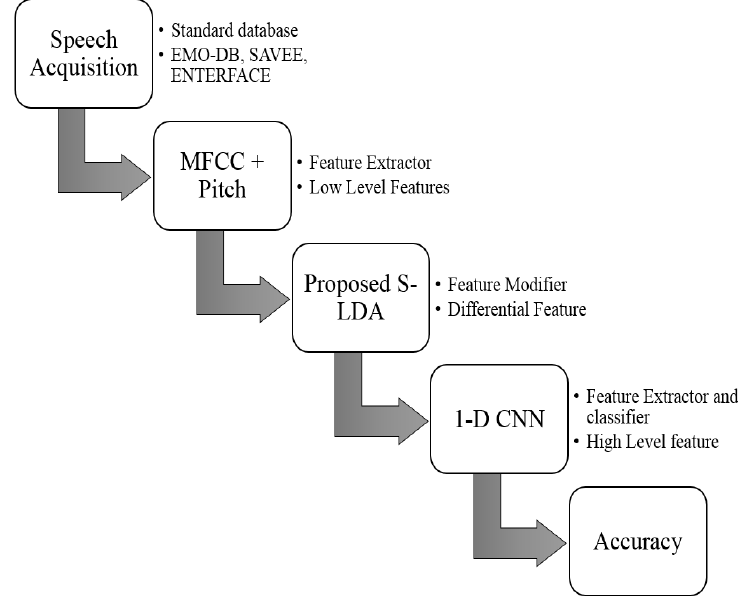
Figure 1. Proposed AER